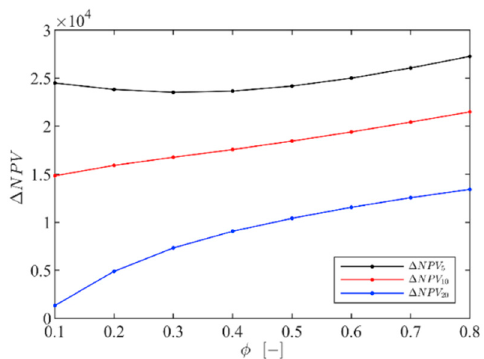
Figure 15. Difference of Net Present Value (NPV) vs the runoff coefficient ( φ ), for different time Figure 15. Di ff erence of Net Present Value (NPV) vs the runo ff coe ffi cient ( ϕ ), for di ff erent time periods periods (5, 10, and 20 years) [22]. (5, 10, and 20 years)